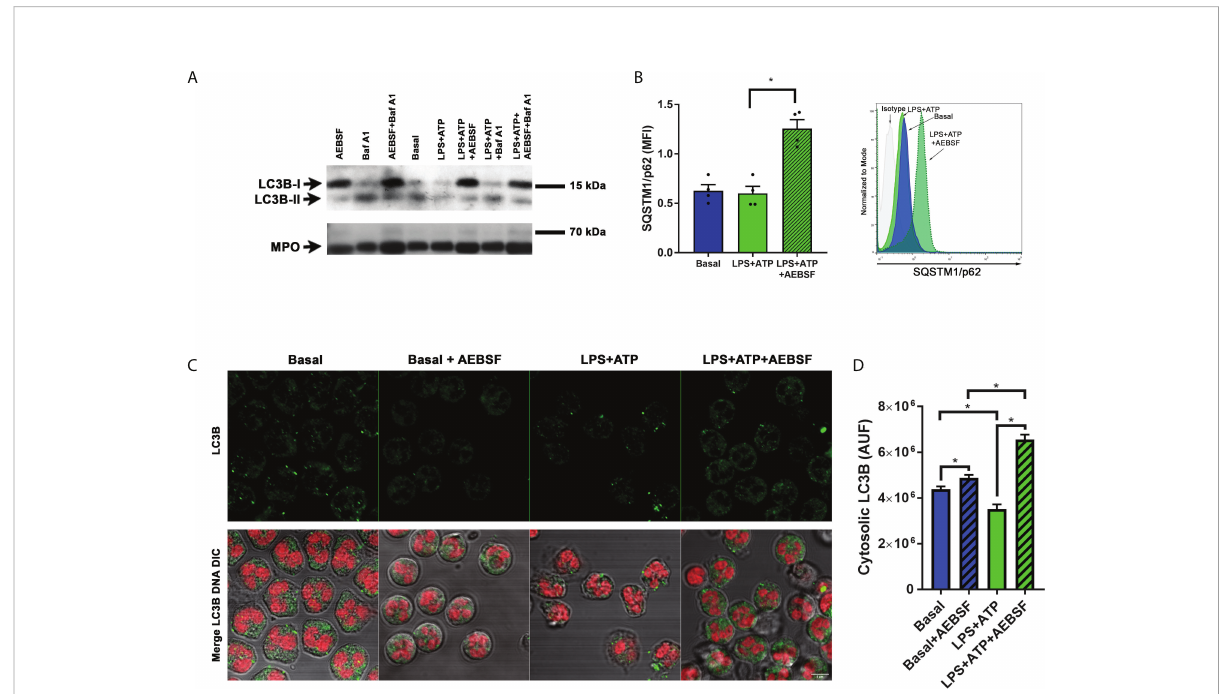
FIGURE 2 Treatment of neutrophils with AEBSF inhibits autophagy induction. (A) Immunoblot analysis of LC3B in lysates of human neutrophils pre-treated or not with AEBSF (0.35 mM; t= -30 min), then stimulated or not with LPS (t= 0); treated or not with the autophagy fl ux blocker Baf A1 (t= 1 h), and with ATP (t= 2 h), assessed at 2 h and 15 min post-LPS stimulation. Immunoblot is representative of 2 independent experiments. Myeloperoxidase (MPO) was employed as loading control. (B) Median fl uorescence intensity (MFI) levels of the autophagy receptor p62/SQSTM1 evaluated by immunostaining and fl ow cytometry at 2 h and 15 min post-LPS stimulation. Data represent the mean ± SEM of experiments performed with 4 donors (left) and representative histograms of one of these experiments (right). *p < 0.05. One-way ANOVA followed by Holm-Sidak ’ s multiple comparisons test. (C) Representative CLSM images of neutrophils pre-treated or not with AEBSF and stimulated or not with LPS+ATP for 4 h. Cells were stained with a speci fi c antibody anti-LC3B and the corresponding secondary antibody and DNA was stained with ToPro-3. Images are representative of experiments with 3 different donors. (D) Quanti fi cation of the images of experiments performed with 3 donors as shown in (C) Data represent the fl uorescence corresponding to cytosolic LC3B expressed in arbitrary units of fl uorescence (AUF). *p<0.05. Kruskal-Wallis